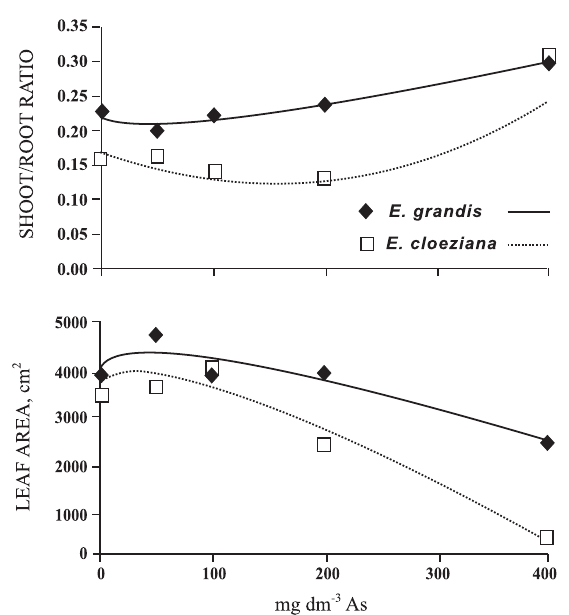
Figure 3 Shoot/root ratio and leaf area of E. grandis and E. cloeziana seedlings as related to the As dose applied to the